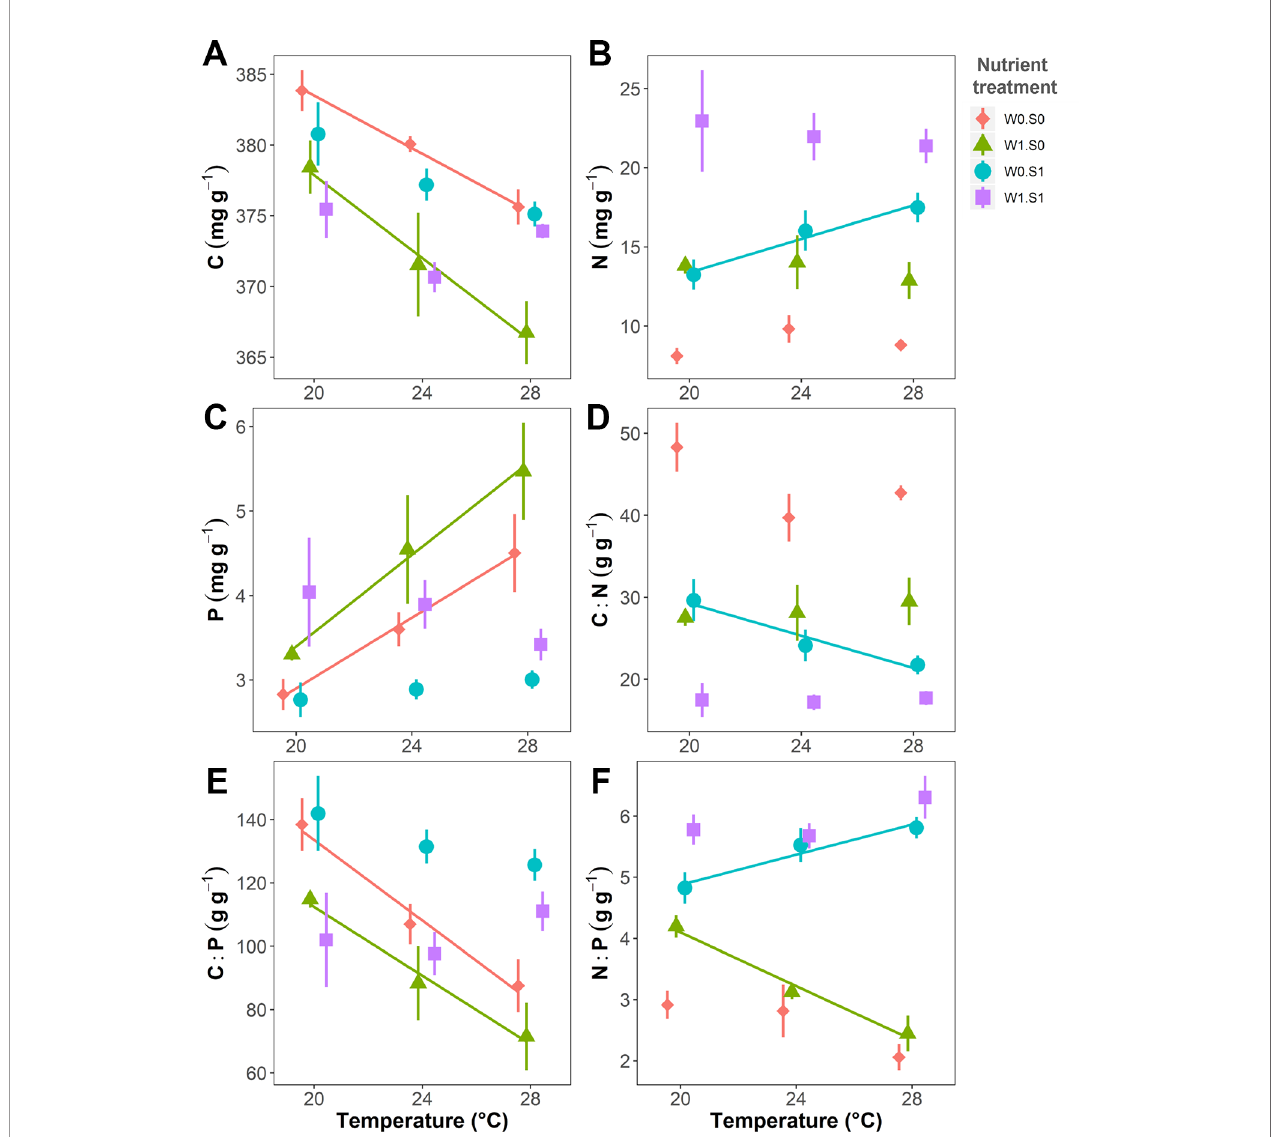
FIGURE 4 | Temperature effects on plant elemental composition (C, N, and P contents) and stoichiometry (C:N, C:P, and N:P ratio) in dry weight indicated per nutrient treatment. (A) Plant C content, (B) N content, (C) P content, (D) C:N ratio, (E) C:P ratio, and (F) N:P ratio. Nutrient treatments are as indicated in Figure 2 . A solid line indicates p < 0.05, and vertical bars are standard errors (n =